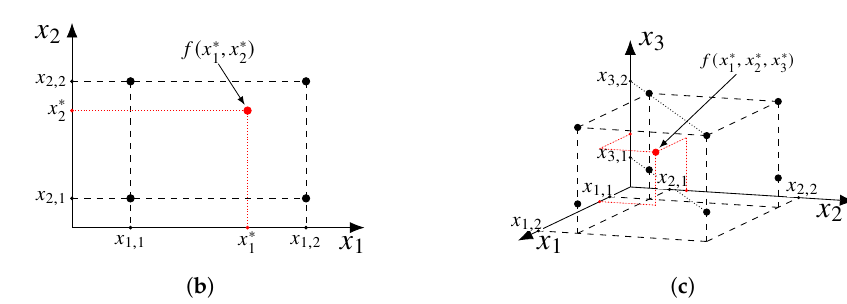
Figure 2. Examples of regular grids for ( a ) D = 1, ( b ) D = 2 and ( c ) D = 3 showing the number of vertices surrounding the point where the interpolant must be calculated. The number of vertices , i = 1, . . . , D where the interpolant is to be calculated is 2 D surrounding a point x ∗ i